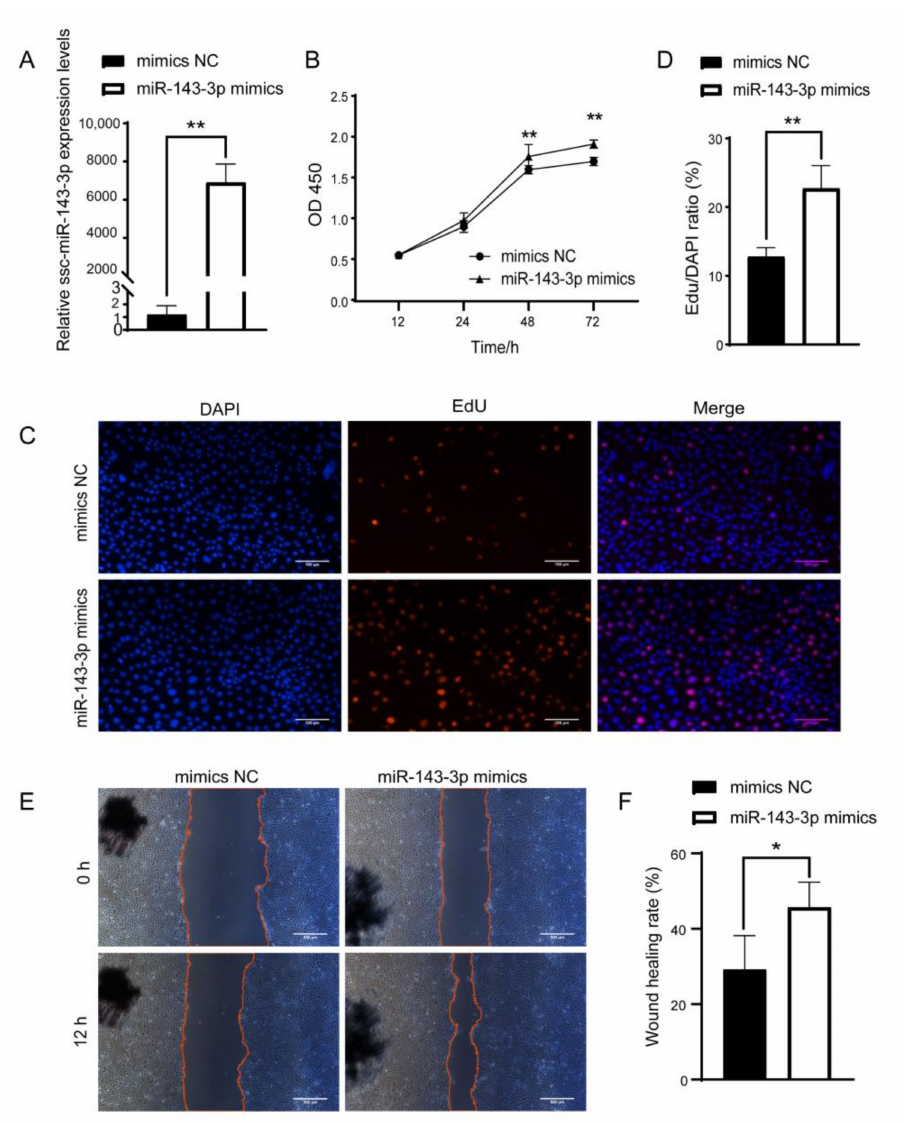
Figure 4. Upregulation of ssc-miR-143-3p promotes the proliferation and migration of porcine trophoblast cells (PTr2 cells). ( A ) The efficiency of ssc-miR-143-3p overexpression was examined by RT-qPCR. ( B ) Cell proliferation was detected by CCK-8, and ssc-miR-143-3p overexpression was found to promote the proliferation of PTr2 cells. ( C , D ) Altered cell proliferation after overexpression of ssc-miR-143-3p was detected by EdU. Scale bar = 100 µ m. ( E , F ) Cell migration was detected by wound closure assay. Cells were photographed after 0 h and 12 h of cell damage, respectively.